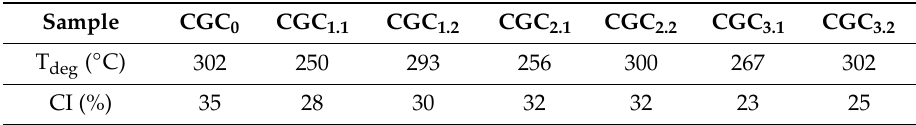
Table 3. Degradation temperature (Tdeg) and crystallinity index (CI) of the original. CGC (CGC 0 ) and polymer samples regenerated from the NaOH / urea solvent